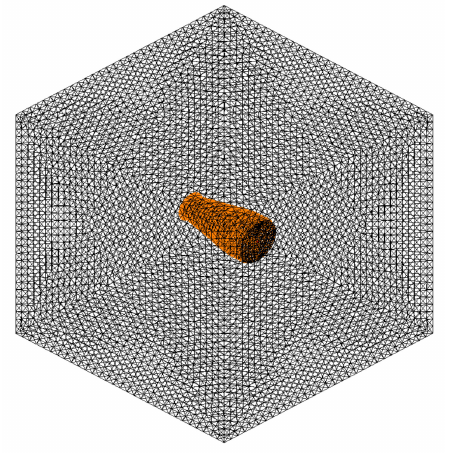
Figure 2. Fluid–structure coupled finite element